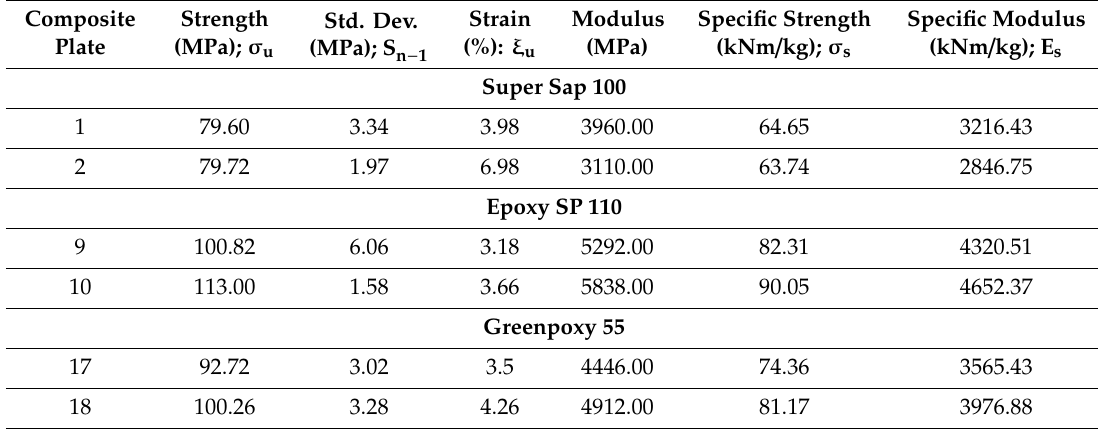
Table 3. Bending properties of hemp fibre